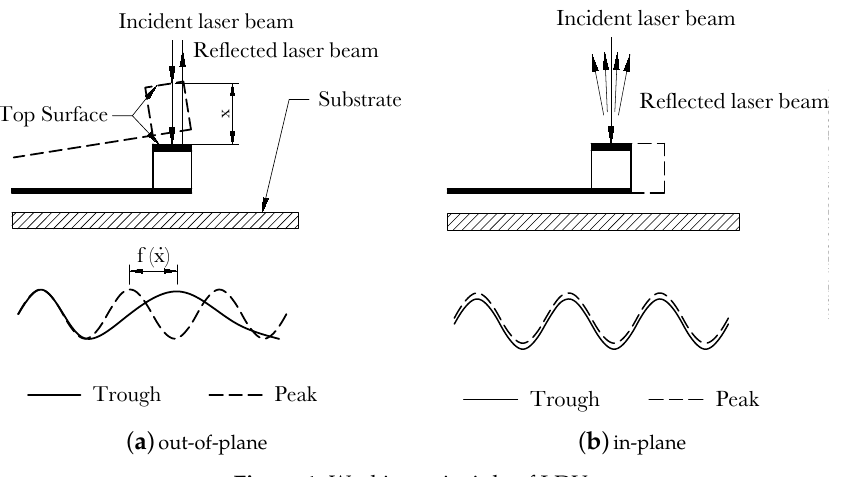
Figure 1. Working principle of